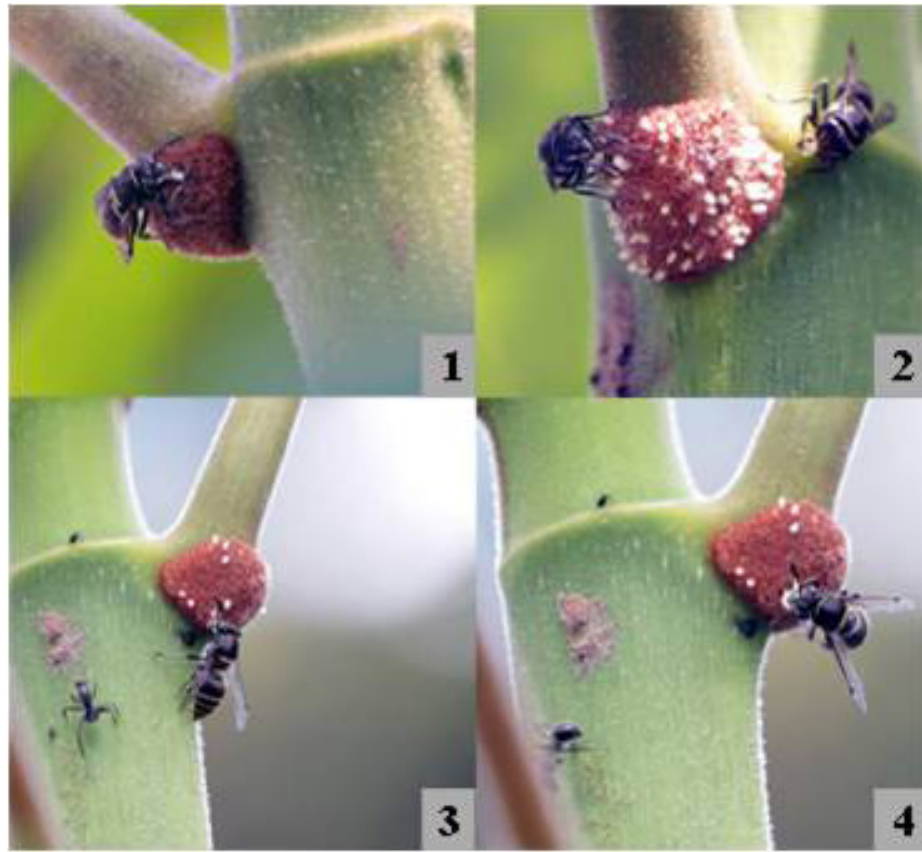
Figs 1–4. Protopolybia chartergoides and Camponotus sp. on Cecropia obtusifolia . 1-4, P. chartergoides individuals collecting Mullerian bodies; 3-4, interaction between wasp and ant near a trichilium, with evasive behavior of ant. (scales in photographies are similar but not